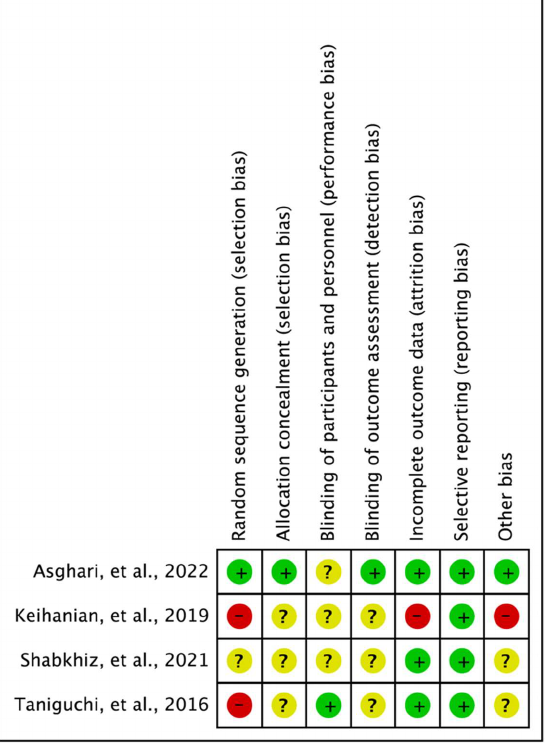
Figure 2. Risk of bias summary [29,30,33,35]. Table 1. Risk-of-bias assessment tool for non-randomized studies.